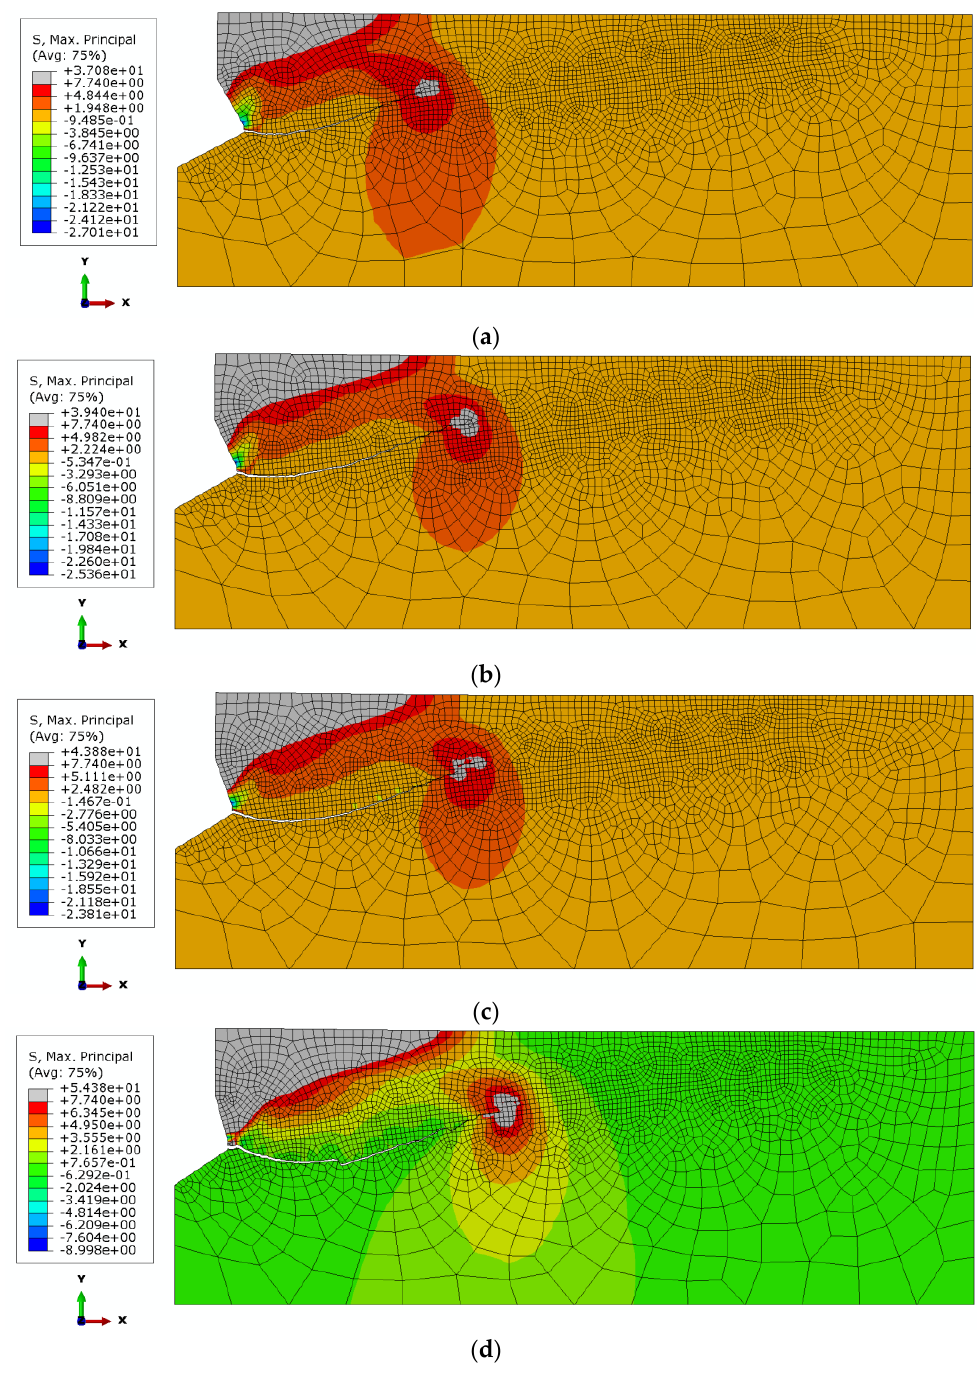
Figure 9. The initial fracture trajectory of the sandstone under the action of the undercutting anchor head, for h ef = 50 mm, μ = 0.2 and head angle β : ( a ) β = 30°, ( b ) β = 25°, ( c ) β = 20°, and ( d ) β = 15°.